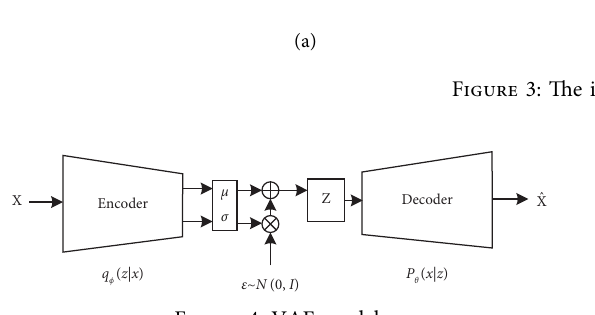
Figure 3: Te idea of the paper.